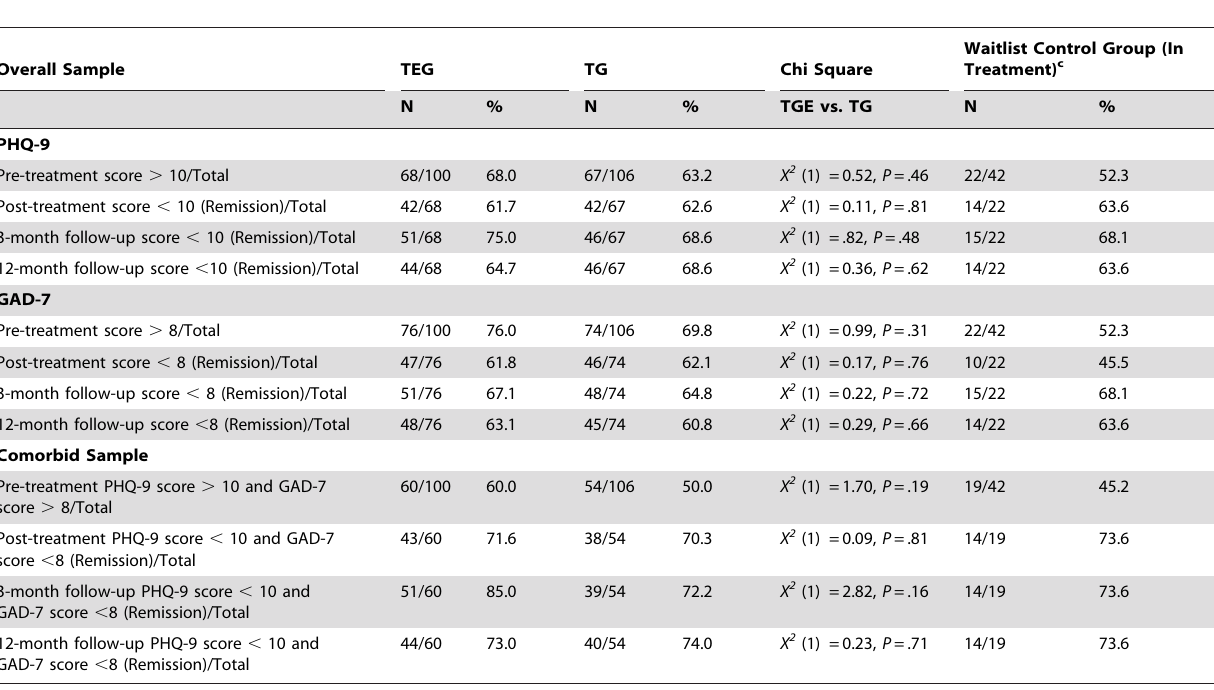
Table 3. Proportion of participants in the Overall and Comorbid Sample, above and below cut-off scores of clinical significance